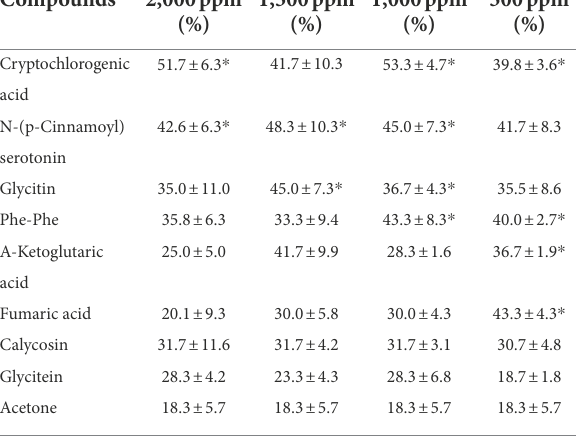
TABLE 5 Effect on immature death rate of Ophraella communa after feeding on common ragweed grown under different treatment